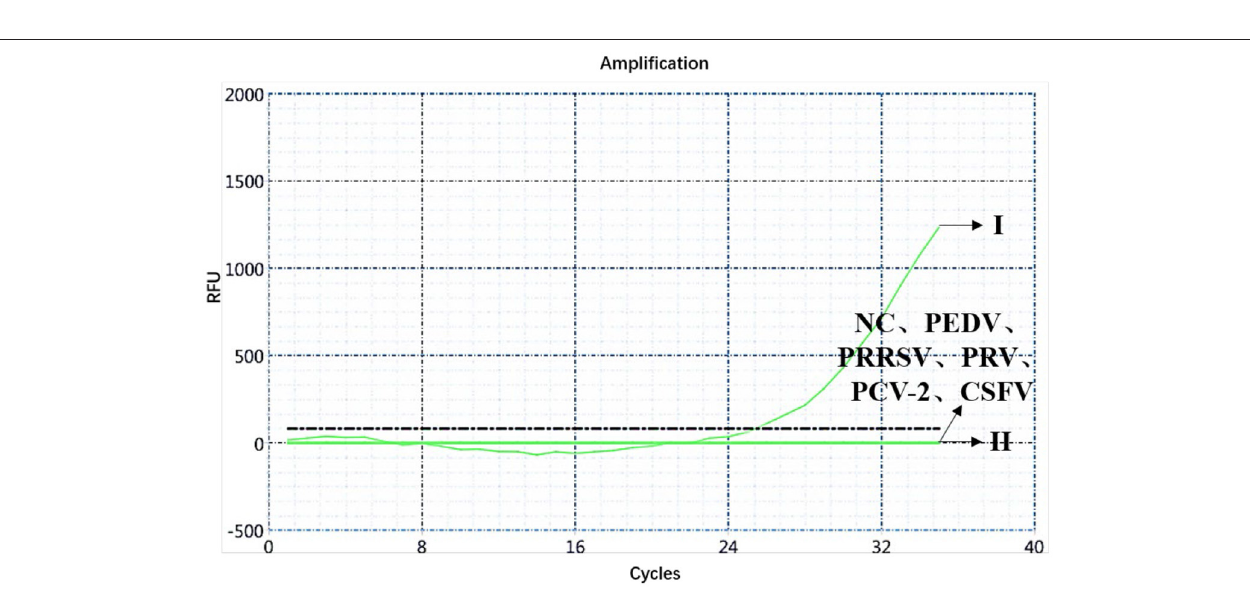
FIGURE 4 | Amplification curve for the HEX channel of ASFV genotypes I and II, PEDV, PRRSV, PRV, PCV-2, CSFV, and negative nucleic acid pig samples determined through dual real-time